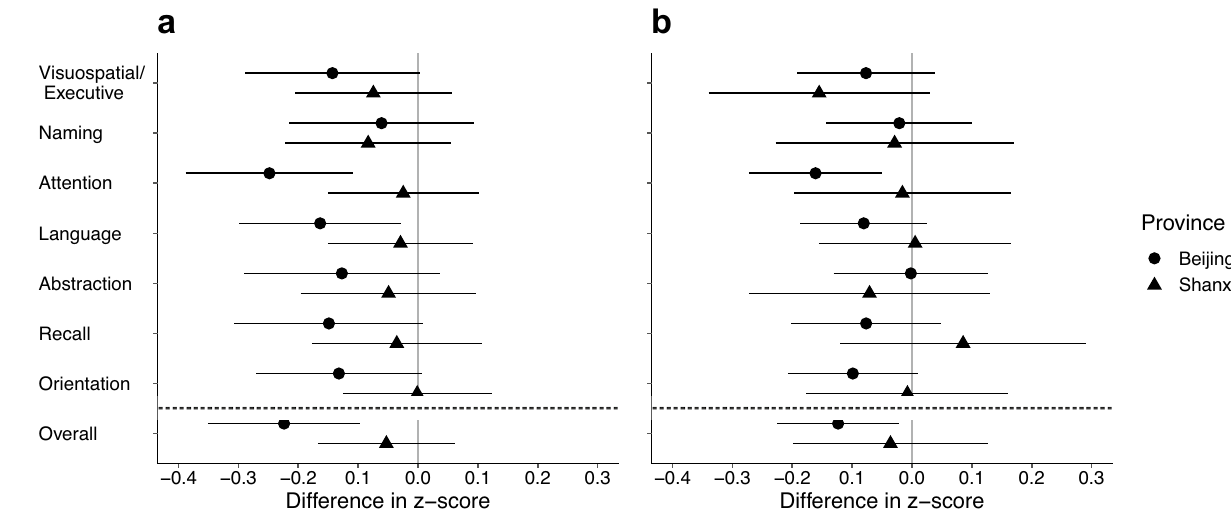
Figure 4. Associations between measures of cognitive function and personal exposures to air pollution in peri- urban northern Chinese adults, stratified by province of residence. ( a,b ) Analyses were performed based on the data of 355 participants. Results from multivariable regression models with province included as an interaction term with exposure variables. Difference in z-score represents the difference in cognitive score associated with an IQR increase in exposure. Data are presented as point estimates of effects (central dots of the error bar with circle representing Beijing and triangle representing Shanxi) with 95% CIs (corresponding solid lines). The vertical solid line is the reference line. The horizontal dashed line separates estimate for overall cognition from estimates for cognitive domains. ( a ) Personal exposure to PM 2.5 (IQR: 53.2 μg/m 3 ) and MoCA scores. ( b ) Personal exposure to black carbon (IQR: 0.9 μg/m 3 ) and MoCA scores. For detailed estimates and interaction p -values, please see Supplementary Table